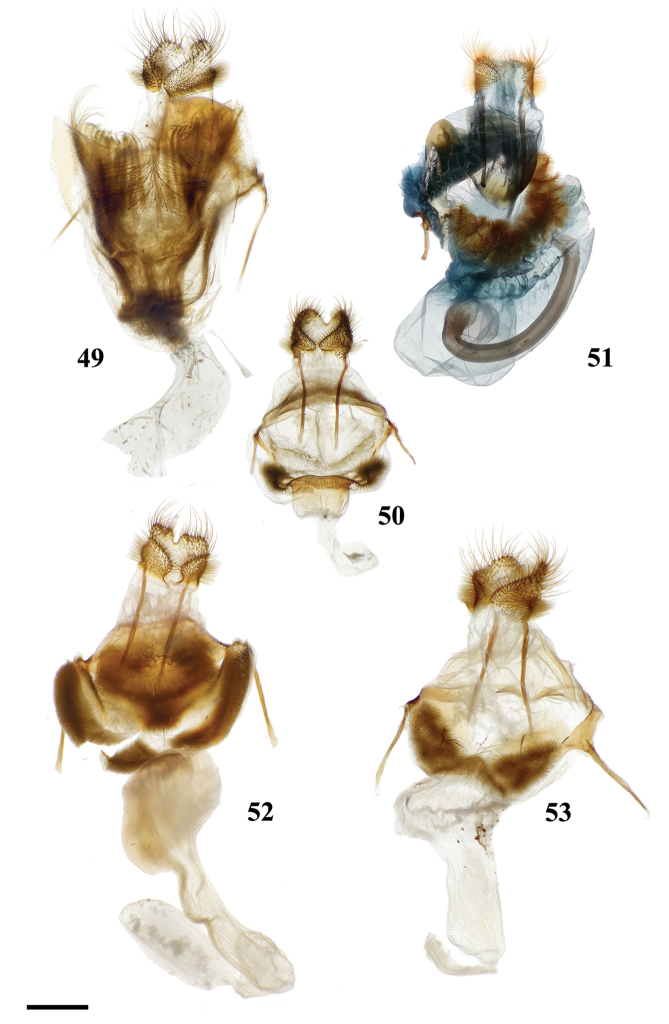
Ventral view of female genitalia of type species (except where noted) of genera belonging to Lacosominae: Alheitini. 49Adalgisacroesa, St Laurent diss.: 4-1-18:1 (CRAS) 50Alheitacfpulloides, St Laurent diss.: 10-10-17:3, not the type species of Alheita (MGCL) 51Taremarivara, St Laurent diss.: 3-14-16:8 [reused with permission from St Laurent et al. (2017b), ZooKeys] (CNC) 52Herbinallacaudina, St Laurent diss.: 9-20-17:2 [reused with permission from St Laurent et al. (2018a), Systematic Entomology] (MGCL) 53Thaelialinamariae, St Laurent diss.: LEP50145 (MGCL). Scale bar: 1 mm.